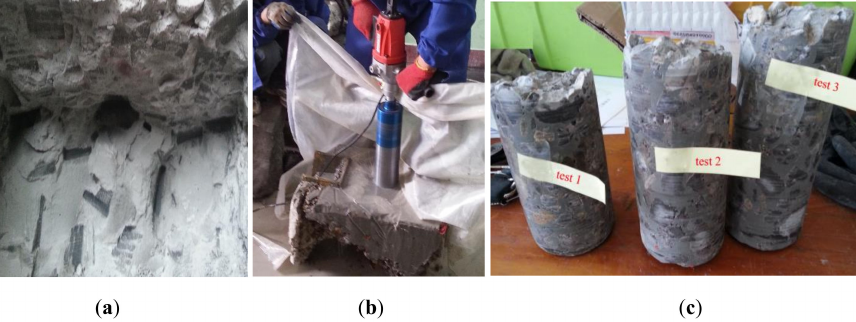
Figure 9. Coring of the grouting stone bodies: ( a ) Grouting stone bodies; ( b ) Coring; and ( c )